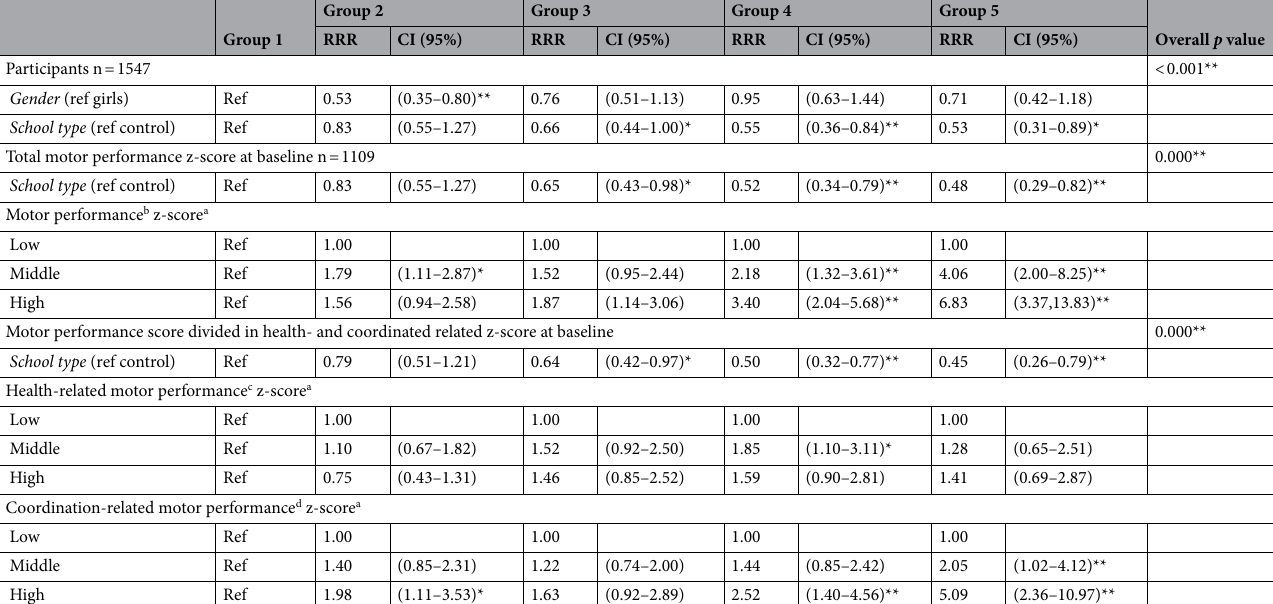
Table 5. Results from multinomial logistic regression of the sports participation trajectory groups and gender, school type, and motor performance. Group 1 is the subgroup of individuals with the lowest activity level and group 5 is the subgroup of individuals with the highest activity level. * p > 0.05, ** p > 0.01 compared the sports participation trajectory groups with gender, school type, and motor performance. a Total motor performance z-score is stratified for age in categories at the time of motor performance baseline test. Z-score = (variable value − mean of values)/SD. b Including all 6 motor performance tests. c Including the hand grip test and the Andersen test. d Including vertical jump, shuttle run, backward balance, and precision